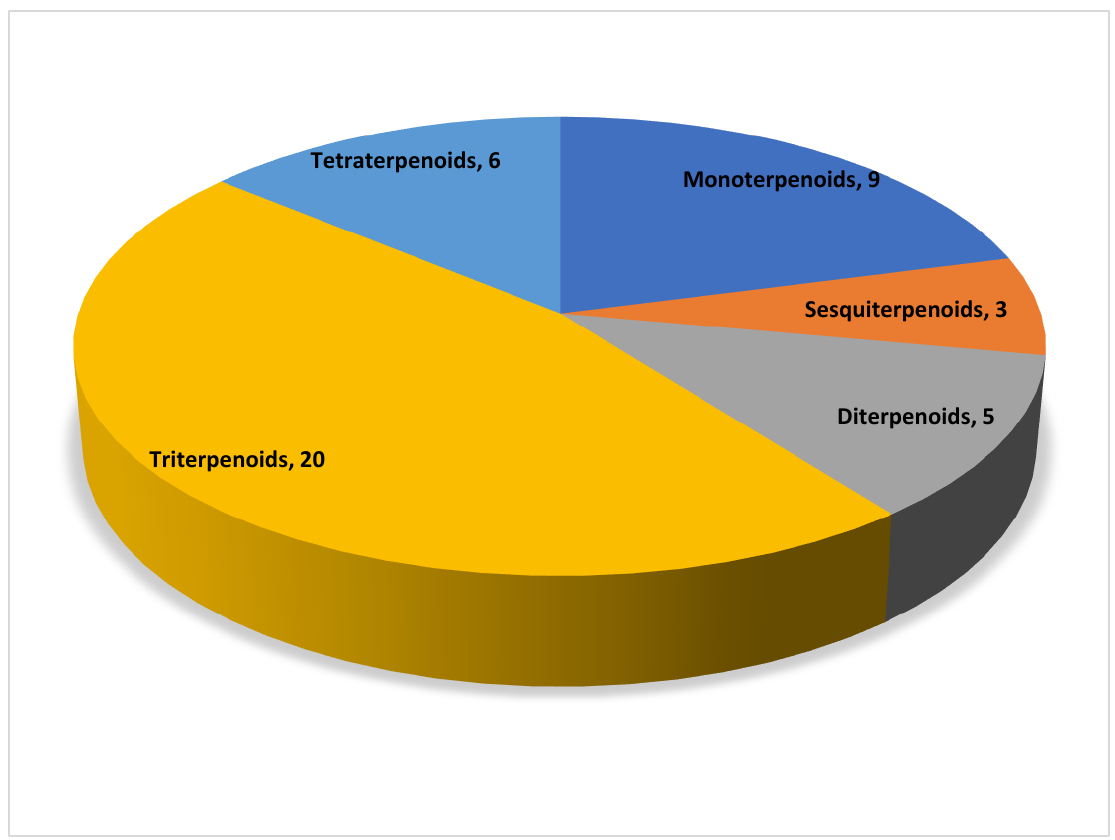
Figure 1. Distribution of different subclasses of terpenoids.